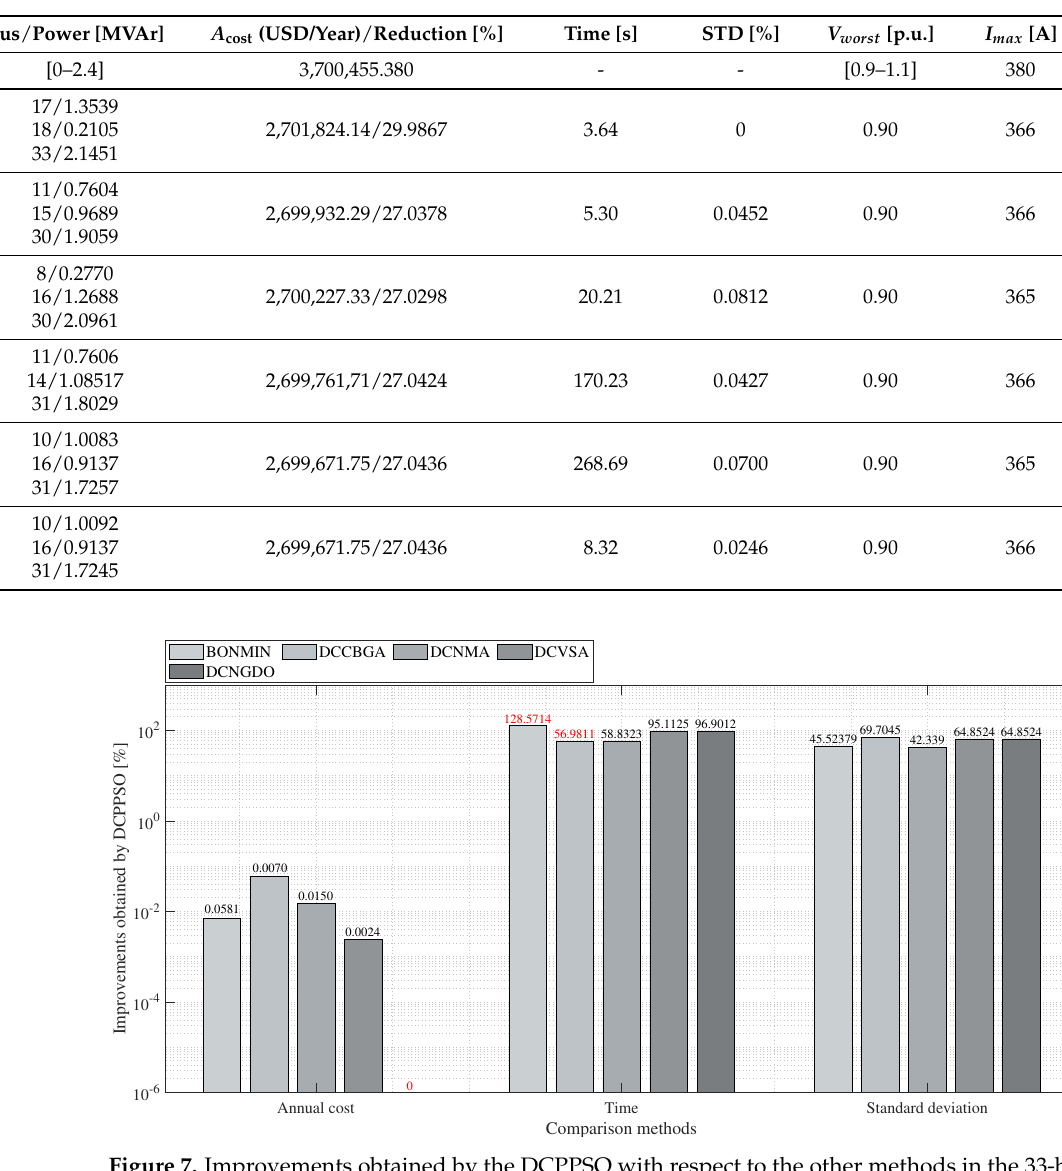
Figure 7. Improvements obtained by the DCPPSO with respect to the other methods in the 33-bus test